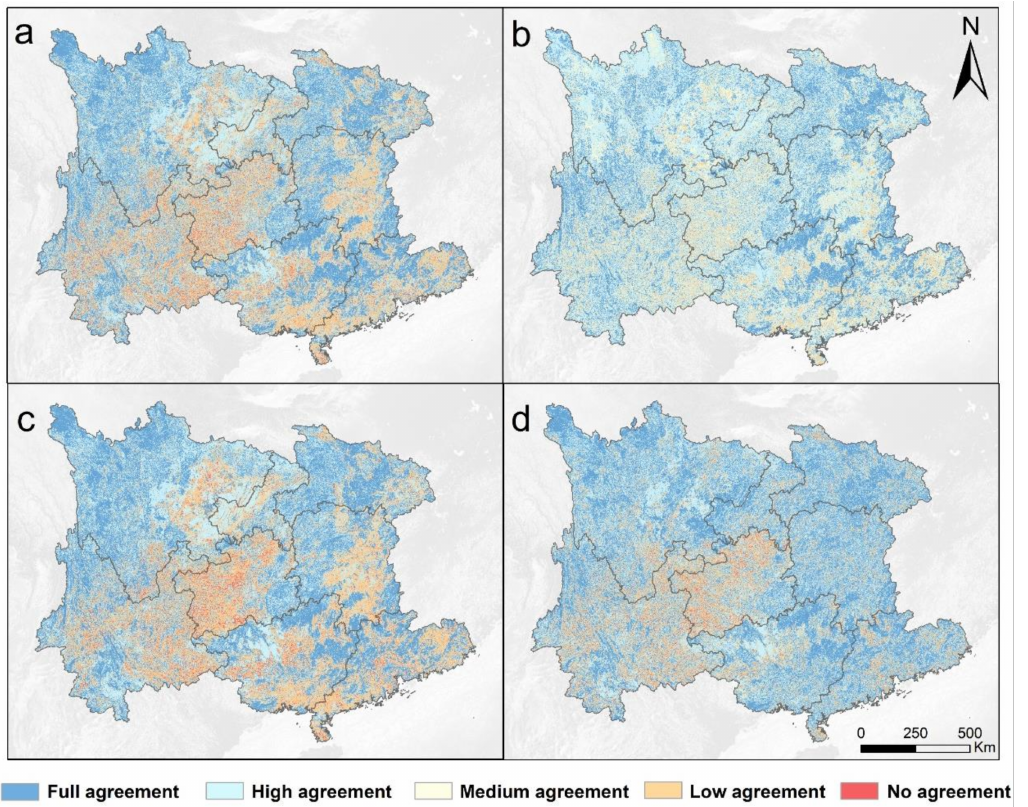
Figure 4. Spatial agreement among different LC maps. Consistency is defined by the number of the LC dataset with the same cover type in each pixel for epochs ( a ) 2000, ( b ) 2010, ( c ) 2015, and ( d ) 2020.